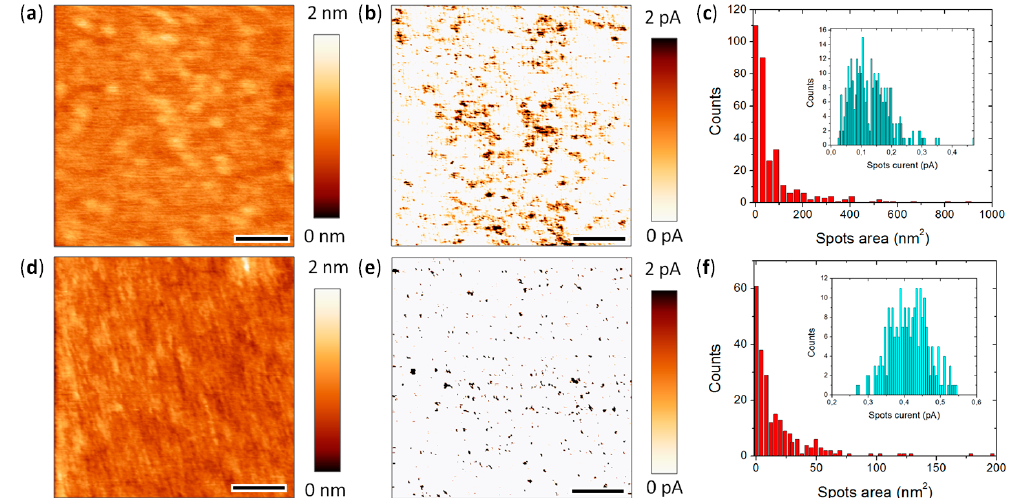
Figure 11. Topographic ( a,d ) and current maps ( b,e ) recorded for as-received (top panel) and graphene-coated AFM tips (bottom panel) on 2.5 nm HfO 2 /Si stack; ( c,f ) Statistical analysis of the conductive spots are measured when scanning the surface of HfO 2 /SiO 2 /Si stack. Reproduced with permission from [29], copyright The Royal Society of Chemistry (2013).